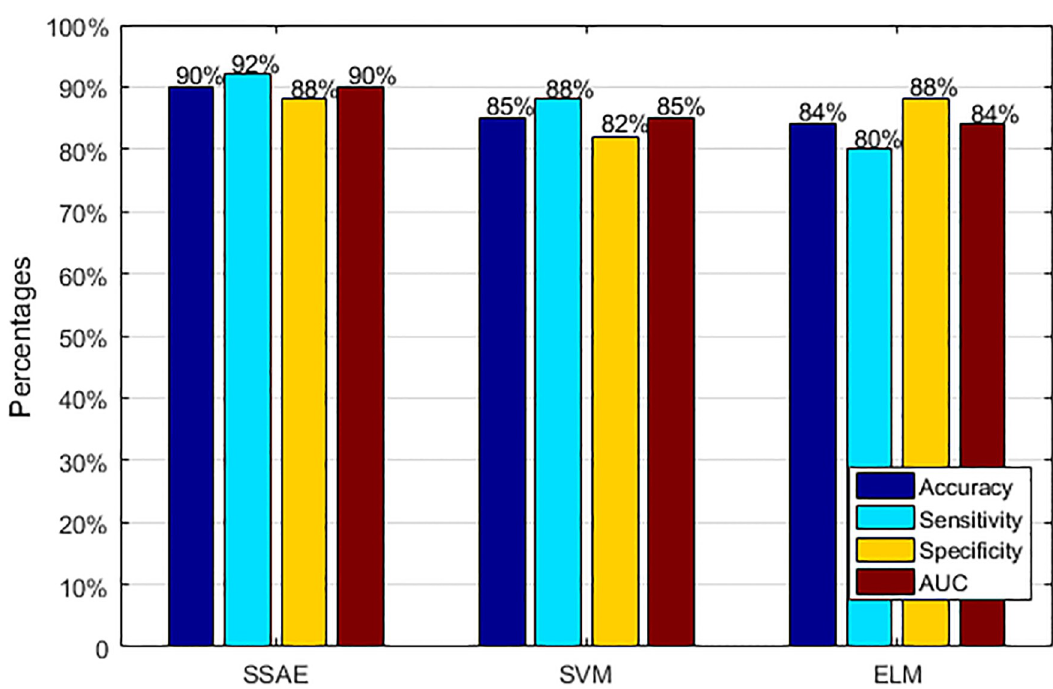
Fig 11. The performance comparison results for the three different classifiers using four